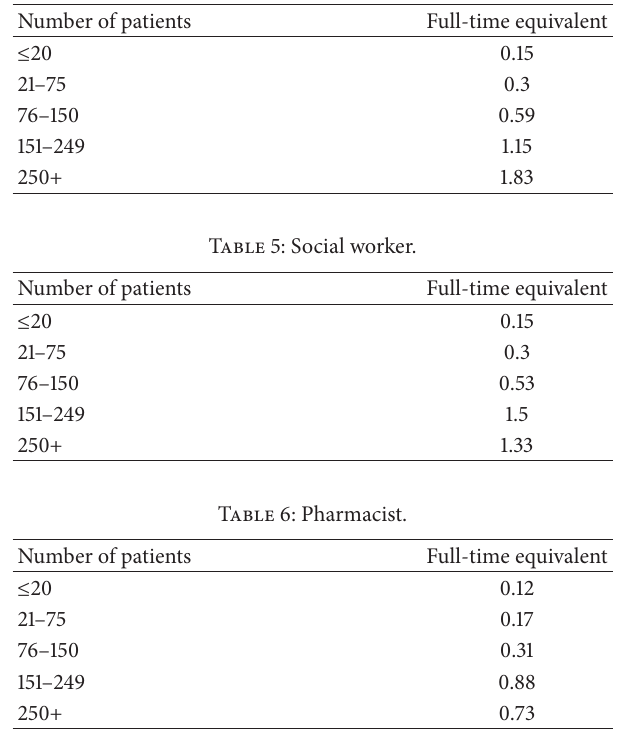
Table 4: Physiotherapist.